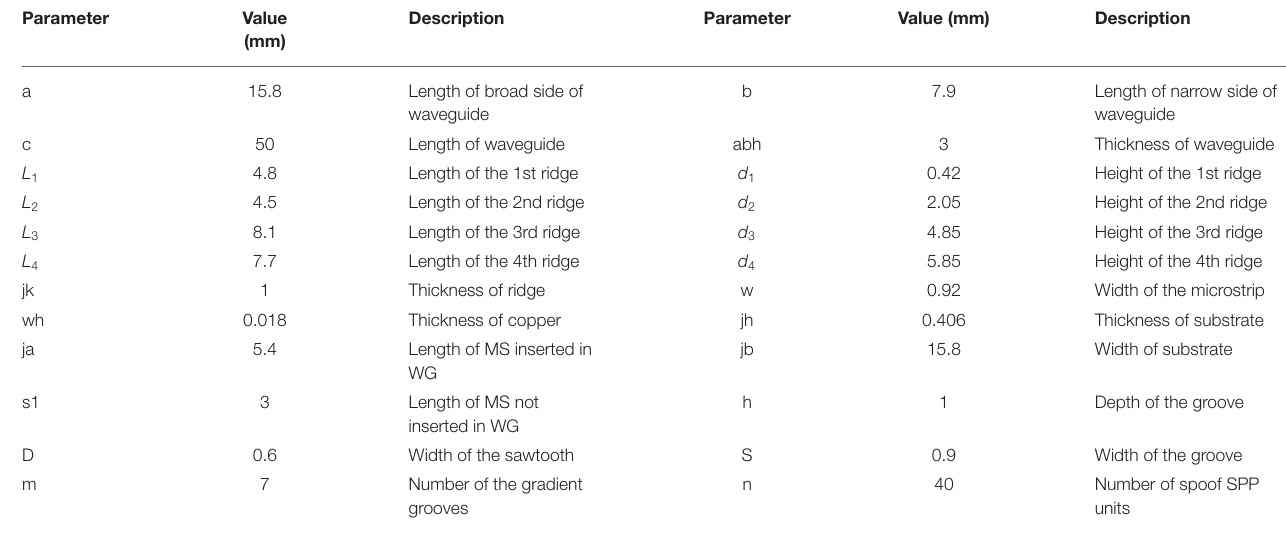
TABLE 1 | Optimized parameters for the